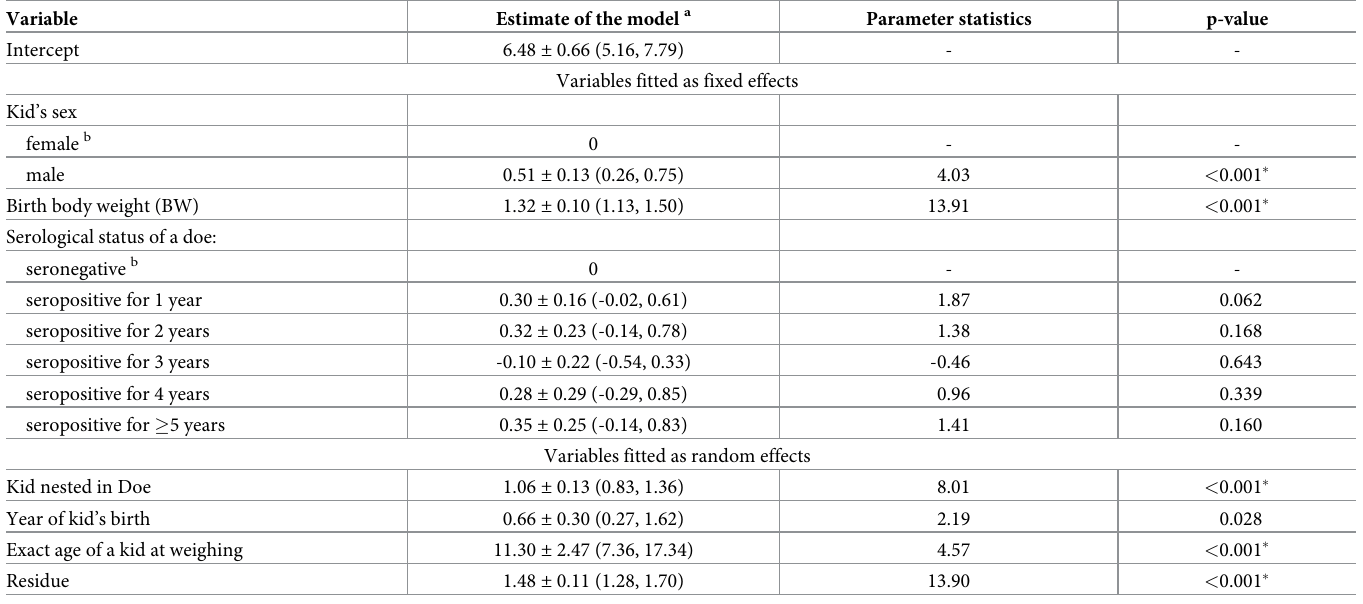
Table 4. Mixed linear model investigating the influence of SRLV infection of a doe on the body weight of an individual kid within the first three months of life